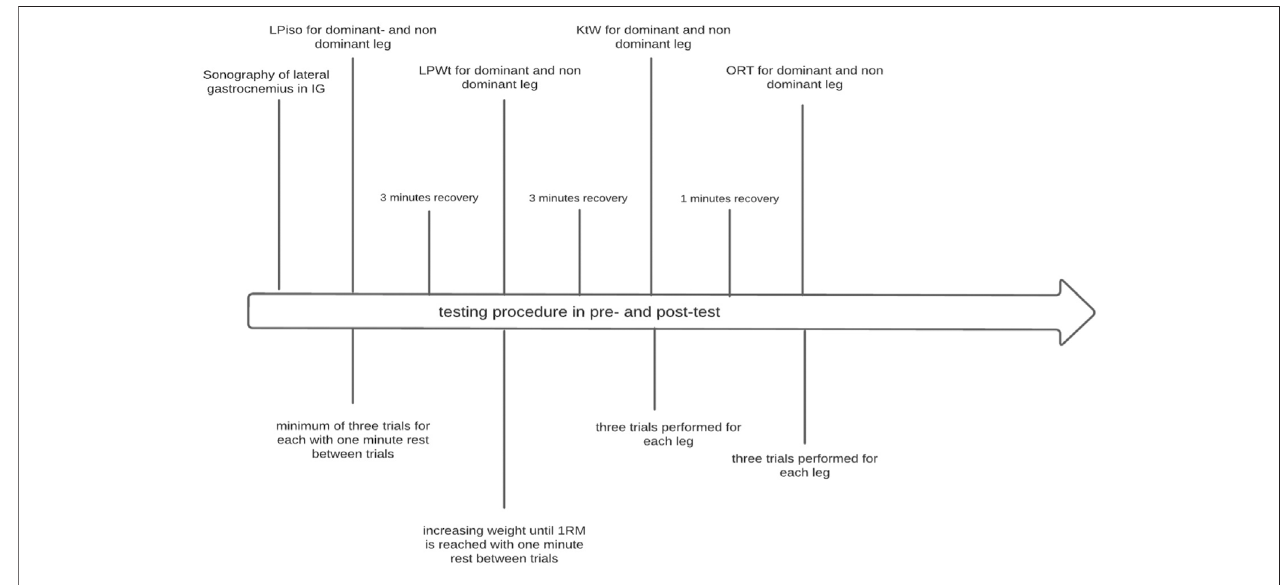
FIGURE 6 | Graphical presentation of study design.